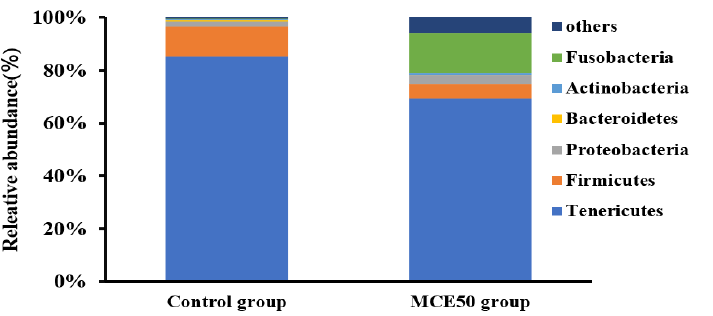
Figure 2. Comparison of intestinal microbiota at phylum level of juvenile American eels between the control group and MCE50 group.